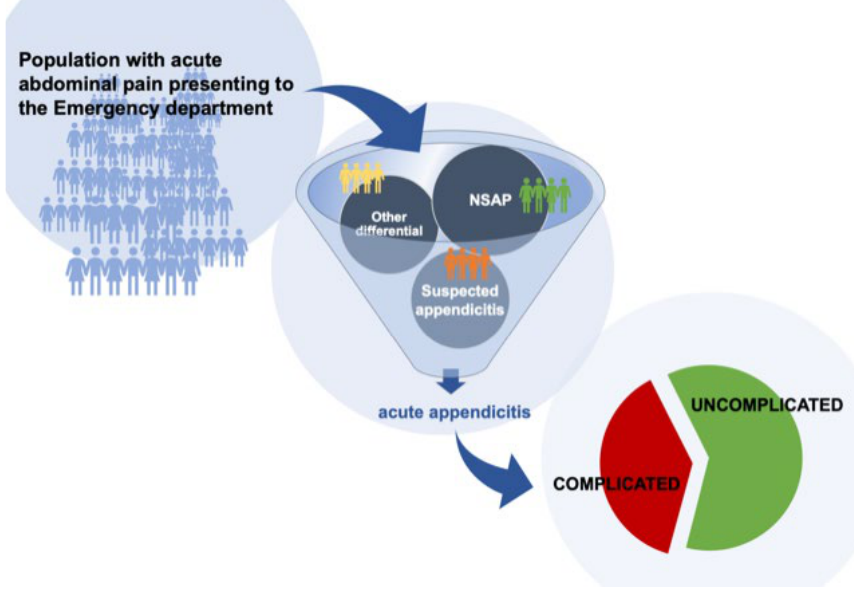
Figure 1. NSAP = Non-Specific Abdominal Pain.